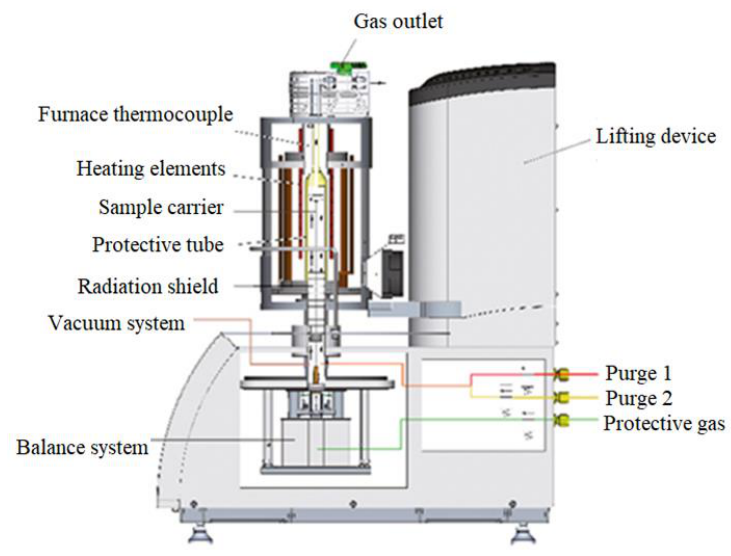
Figure 2. Diagram of the STA 449 F3 Jupiter thermal analyzer.